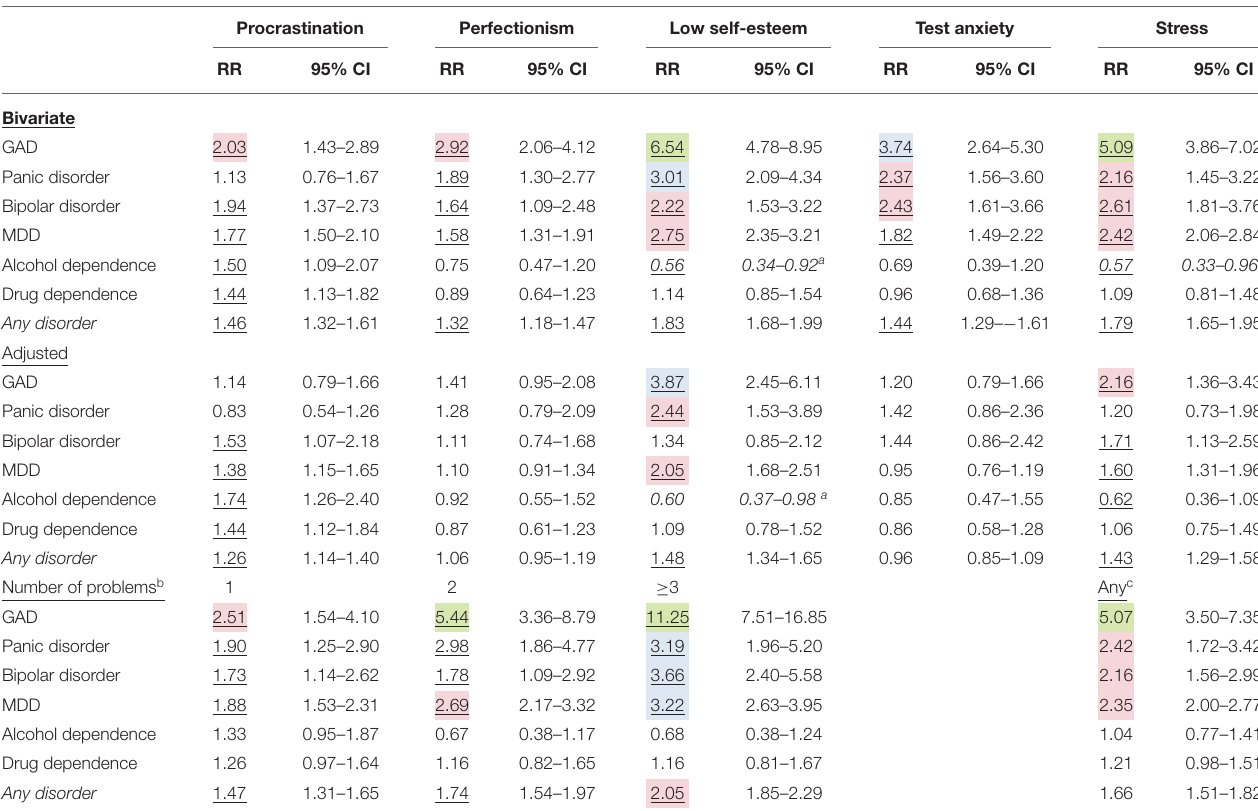
TABLE 3 | Relative risk (RR) of mental disorders among university students reporting common psychological problems: Poisson regression analyses.